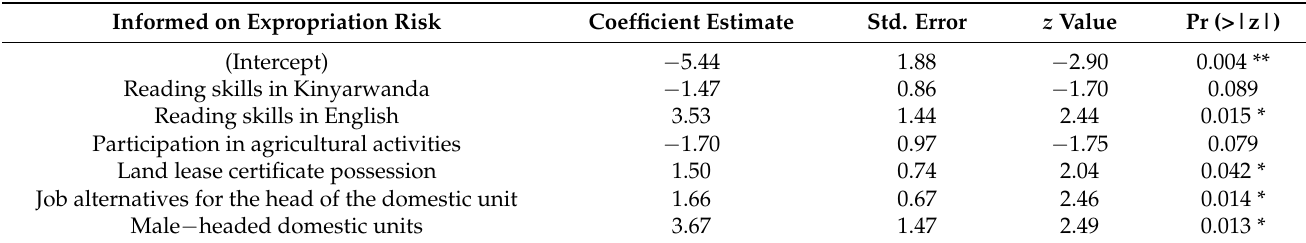
Table 2. Significant variables related to the land user’s information about land